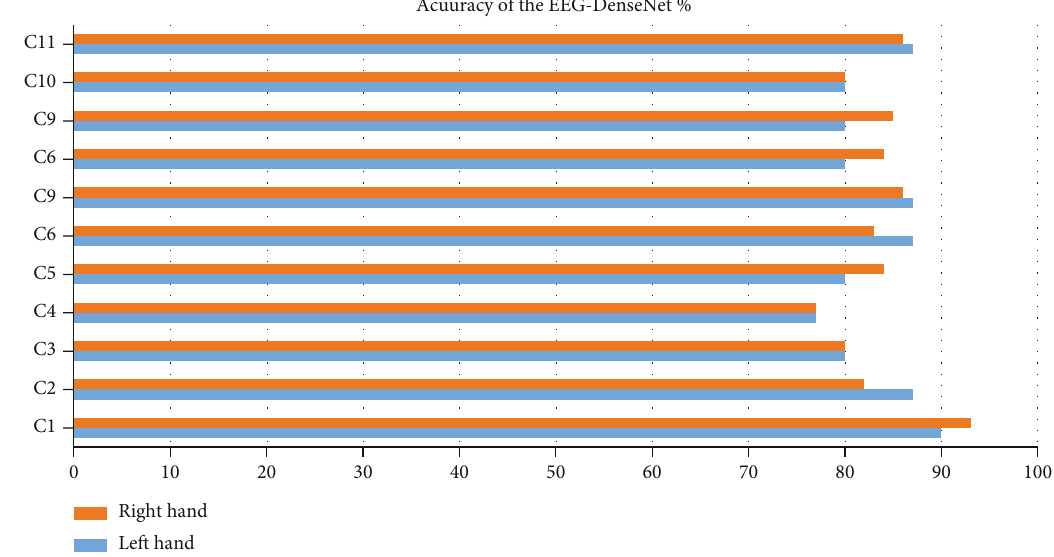
Figure 5: The accuracy of the EEG-DenseNet for 11 cases C1 to C11 (6 healthy: C1 to C6 and 5 brain-injured patients C7 to C11). Table 5: Prediction accuracy results realized by the di ff erent extension models for both hands